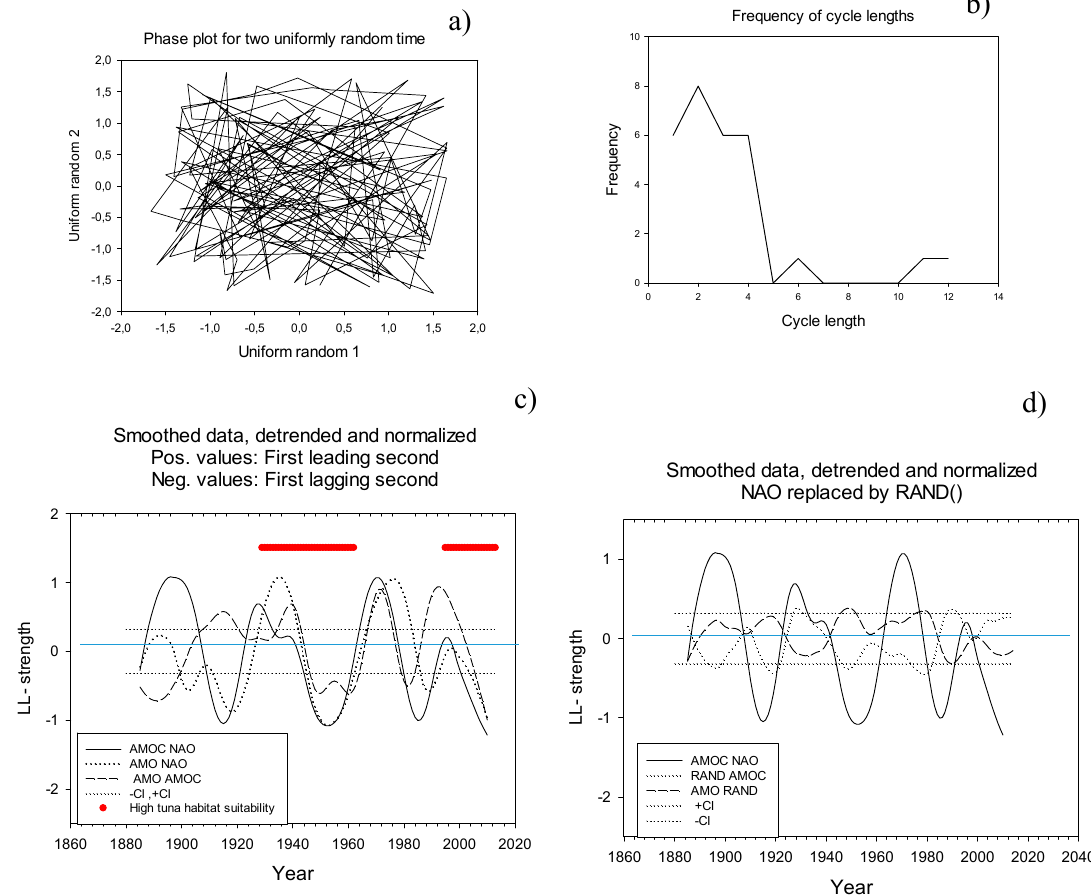
Figure 3. Cycle times and leading-lagging relations. ( a ) Phase plot for two uniform random series, ( b ) Rotations in phase plot that complete a full circle, that is, angles add to 2 π . A similar figure to Figure 3b occurs when the calculations are repeated 100 times. ( c ) Leading-lagging relations between the NAO, the AMOC and the AMO. Figure from Seip and Grøn [6], their supplementary material. Raw series LOESS smoothed f = 0.2, p = 2; LL- relations LOESS smoothed f = 0.2, p = 2. Cycle time for the smoothed series are 21 to 24 years and leading - lagging time 5 to 6 years. Red liners show high tuna habitat suitability in accordance with reference [4]. ( d ) Leading-lagging relations between NAO replaced by the uniform random generator RAND(), and the AMOC and the AMO. The stacked NAO series (raw and LOESS smoothed with increasing degree of smoothing, f = 0.1